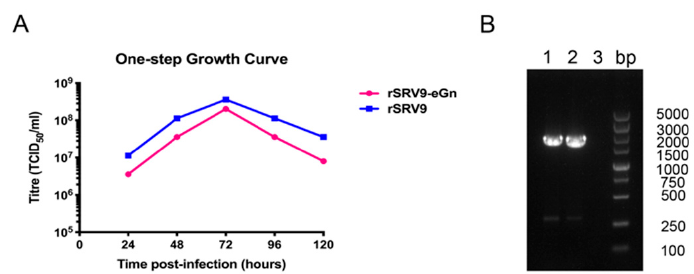
Figure 5. Growth kinetics of recombinant rSRV9-eGn. One-step growth curve comparing the kinetics of live virus replication between rSRV9 (blue) and rSRV9-eGn (pink) in BSR cells. The BSR cells were infected at an MOI of 0.1, and the supernatant was collected at 24, 48, 72, 96 and 120 h. Virus titres were measured by direct immunofluorescence ( A ). Identification of the stability of the insertion of the RVFV eGn gene in the recombinant virus by RT-PCR ( B ).